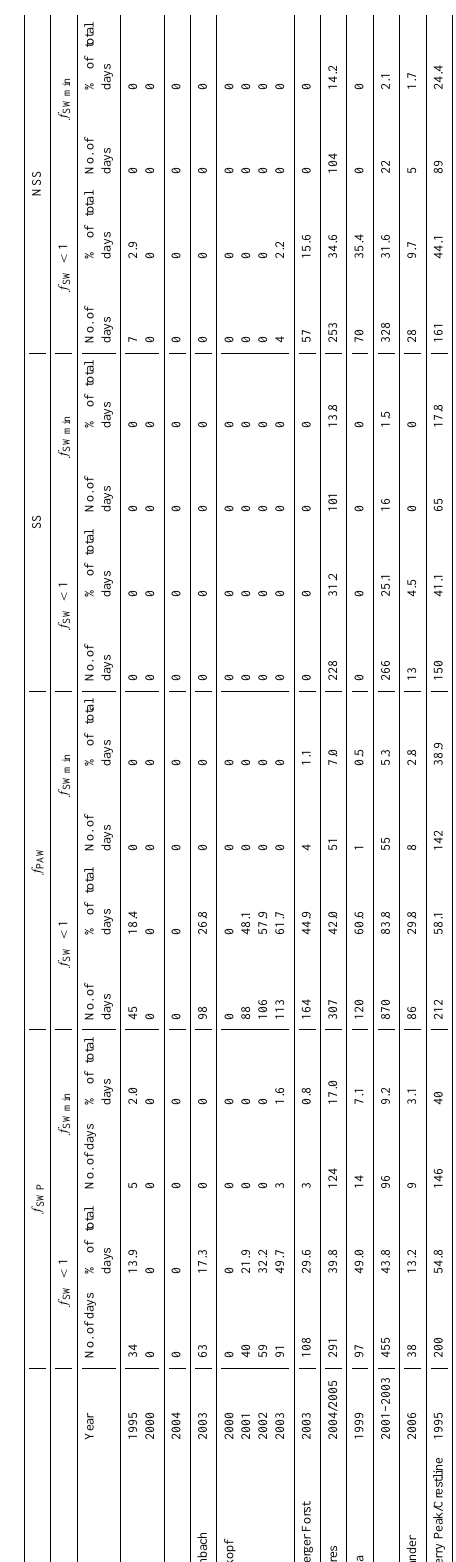
soil water deficits occurred (defined as water deficits that re- sulted in some stomatal limitation for some part of the year as estimated by at least one of the models), the statistics suggest that a ranking of the models with regard to their predictive performance is PAW = SWP > NSS >